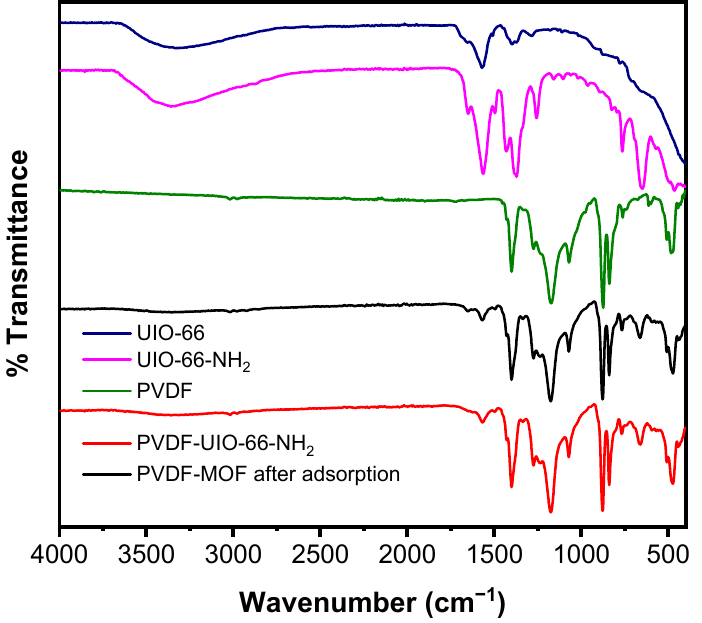
Figure 3. FTIR spectra of UiO-66, UiO-66-NH 2 , PVDF nanofibers, and UiO-66-NH 2 CNM before and after adsorption.